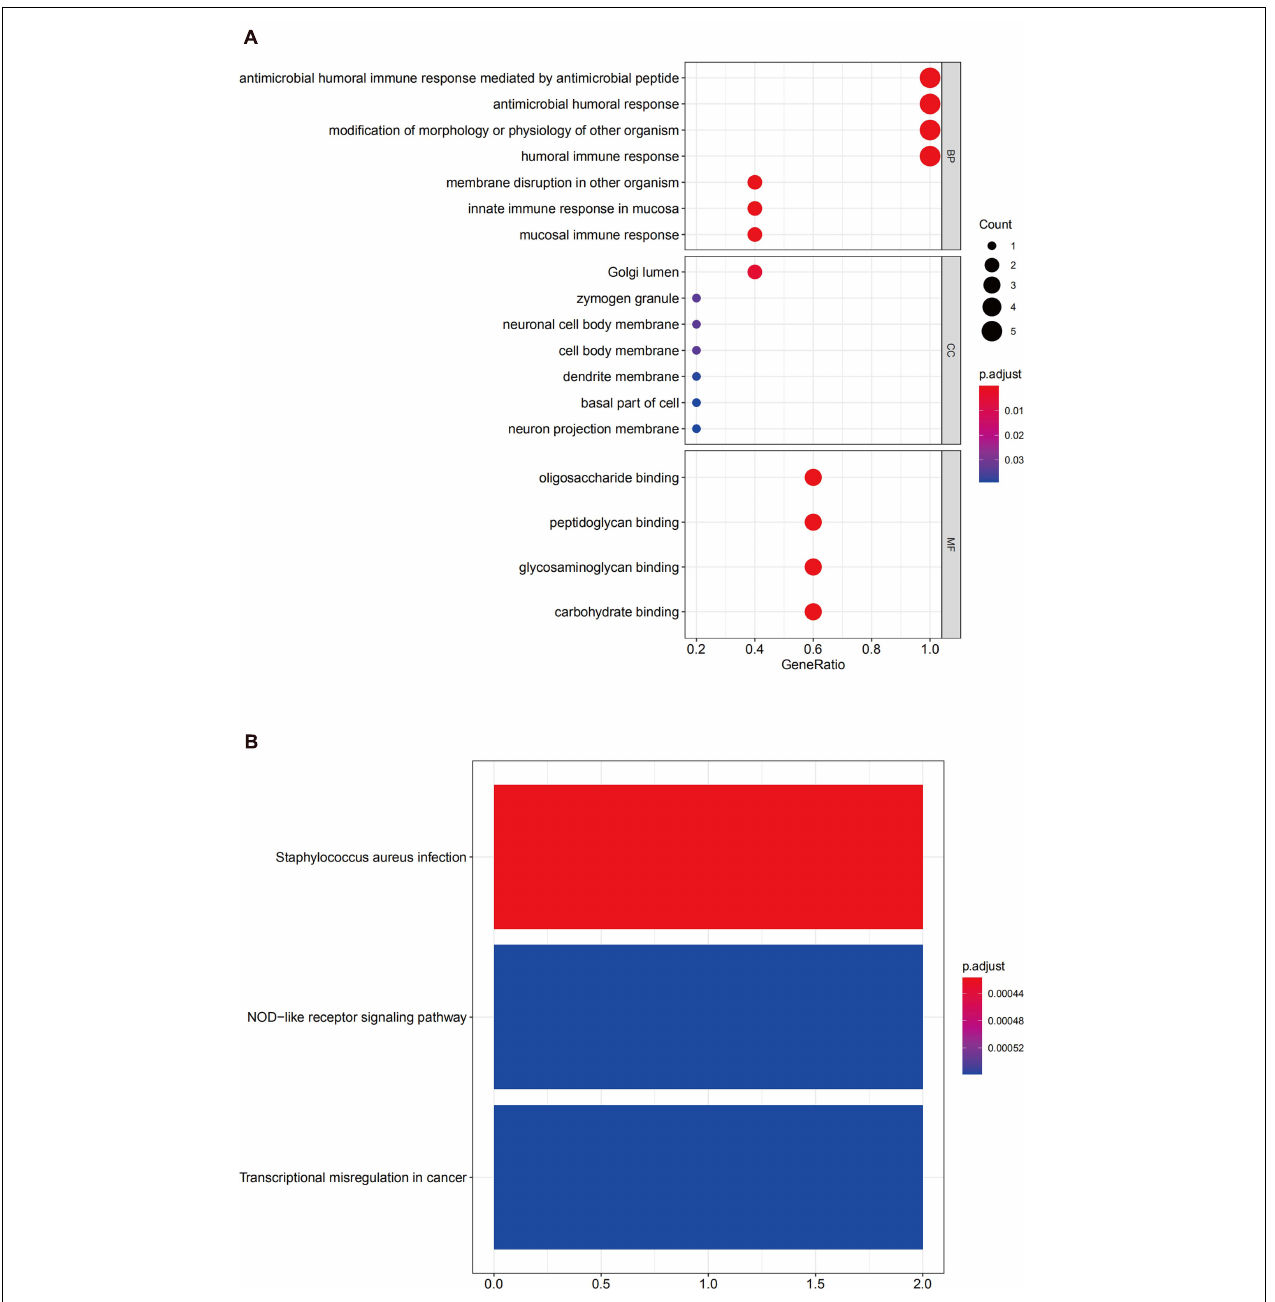
FIGURE 8 | Functional enrichment analysis for the genes in module 2 (A) GO analysis for DEGs. (B) The KEGG analysis for